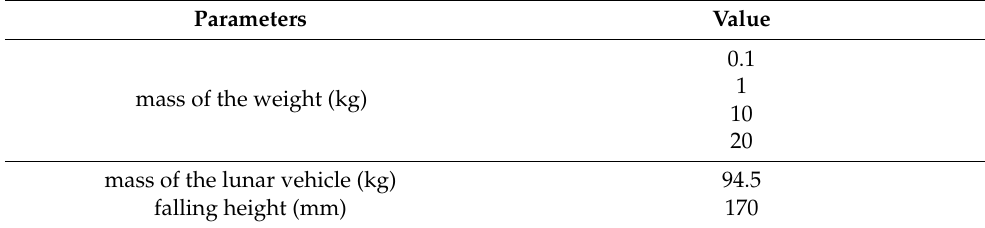
Table 3. The input parameters of landing buffer test. Parameters Value